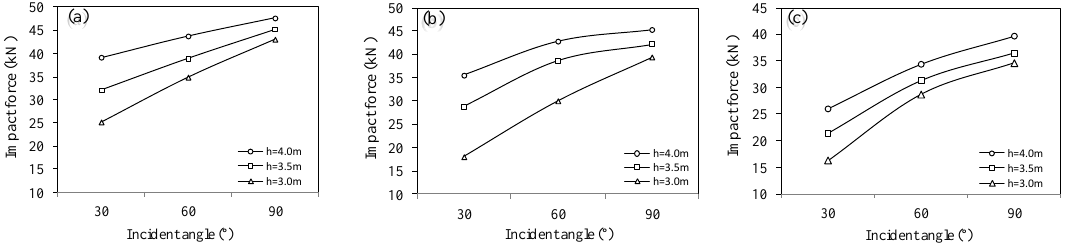
Figure 5. Measured impact force vs. incident angle for samples of different weights: sample weight = (a) 6kg, (b) 5kg, and (c) 4kg.